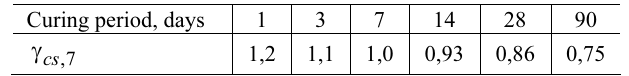
Table 3. Shrinkage correction factor accounts for initial moist curing period